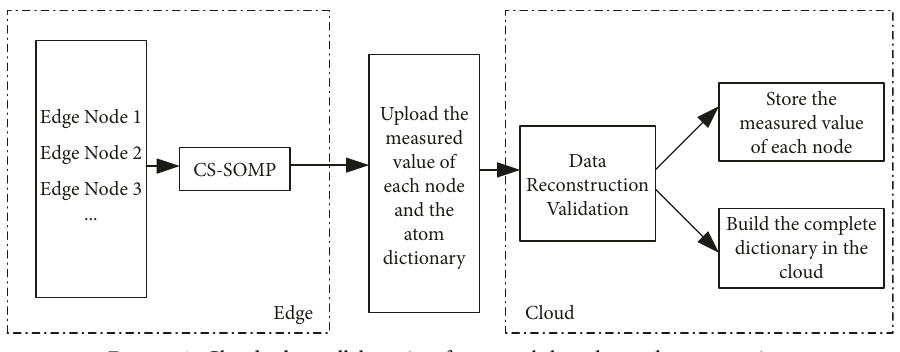
Figure 3: Cloud edge collaboration framework based on edge